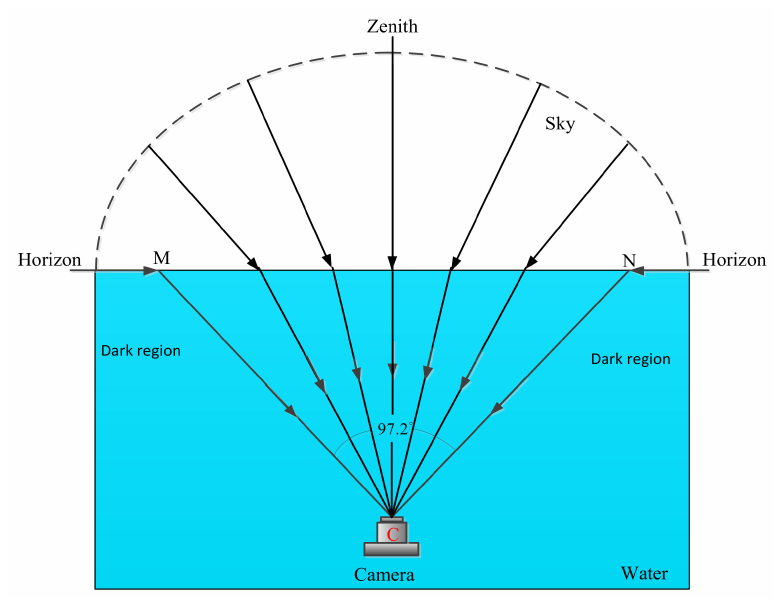
Figure 1. Optics of Snell’s window for flat water.